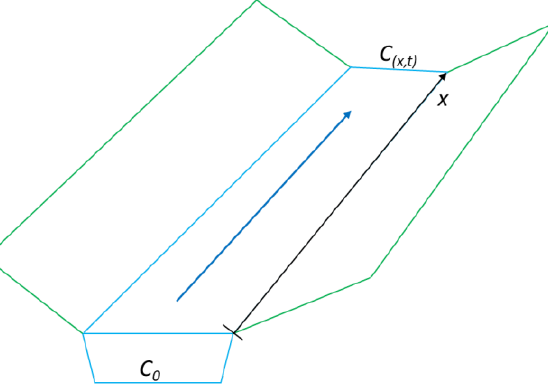
Figure 1. Schematic draw of contaminant movement along a surface water reach.